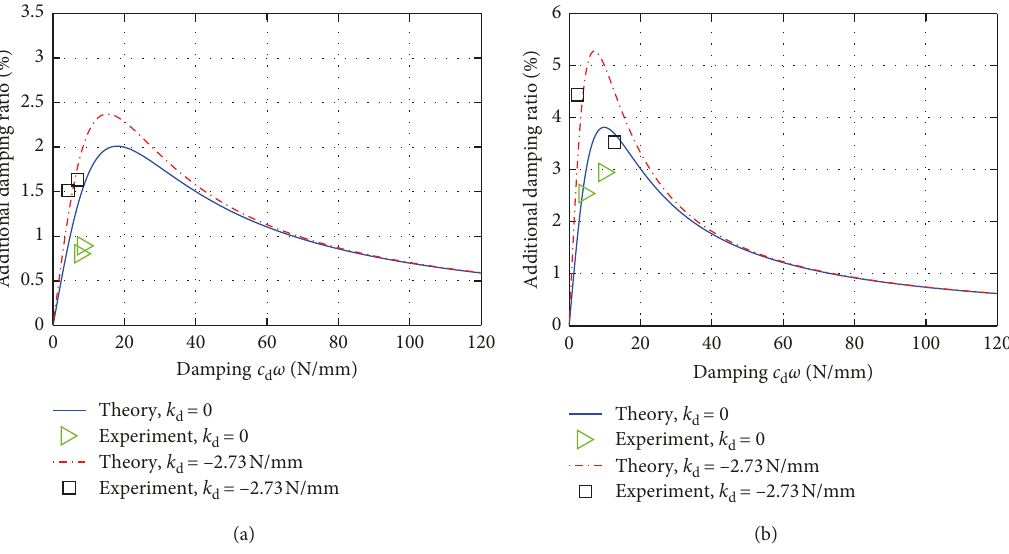
Figure 7: Additional damping ratios provided by the damper: (a) n